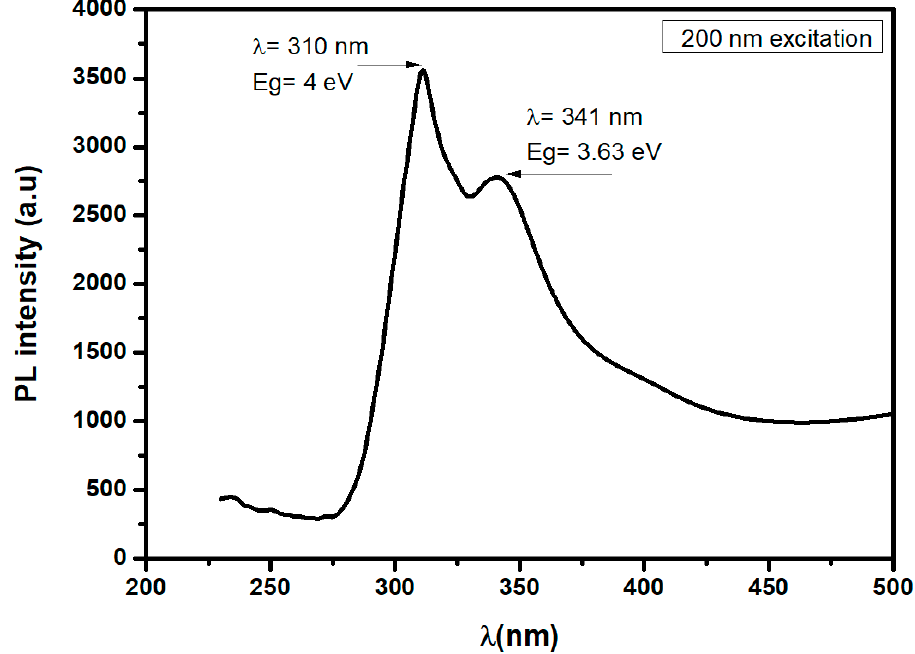
Figure 8. PL emission spectrum for 200 nm excitation of MgO thin films prepared with [Mg 2+ ] = 0.15 mol·L − 1 .